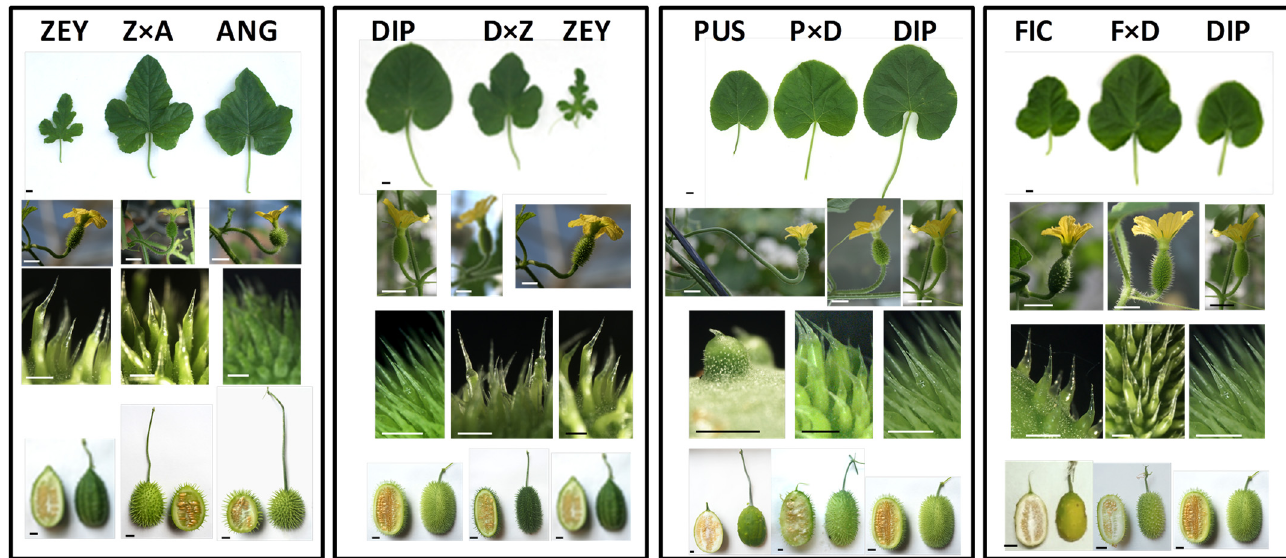
7 of 22 Figure 4. Heatmap of post-zygotic IRBs acting at different reproductive stages in interspecific crosses. Estimated parameters (columns) include seed weight (SW), germination rate (G), fruit set % (FS), fruit weight (FW), and seed number (SN). Interspecific crosses (rows) include those produc- ing at least one fruit. Values for each parameter were estimated relative to seed parent intraspecific controls. The color range from red to blue represents weaker to stronger IRBs to hybridization. 2.6. Post-Zygotic IRBs: Fertility in Interspecific Hybrids A total of eight interspecific F 1 hybrids were obtained in this work. Seven out of them